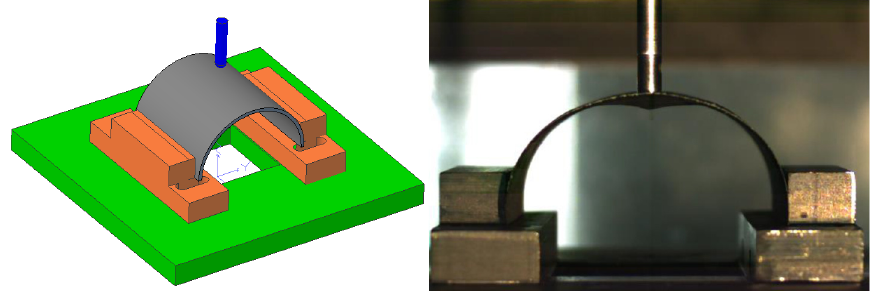
Figure 2. Support used in the experimental tests.